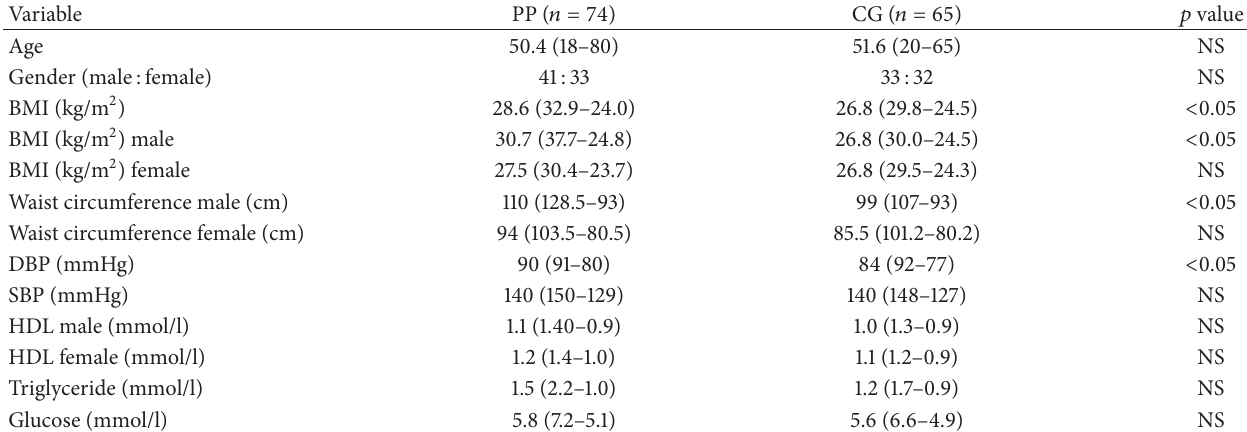
Table 1: Demographics and laboratory findings in the patients (PP) and the controls